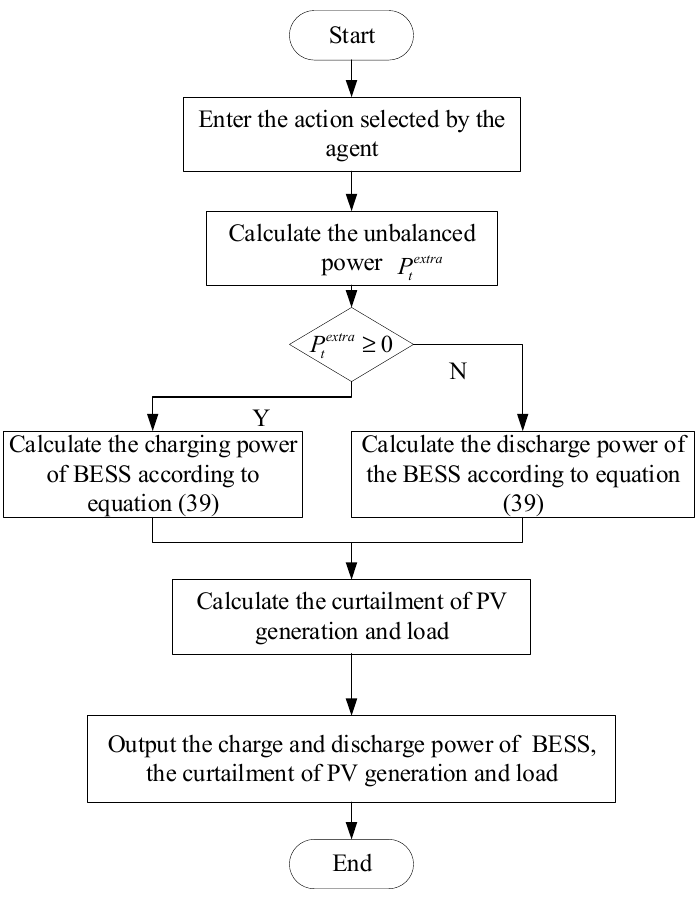
Figure 5. Flowchart of decision making.